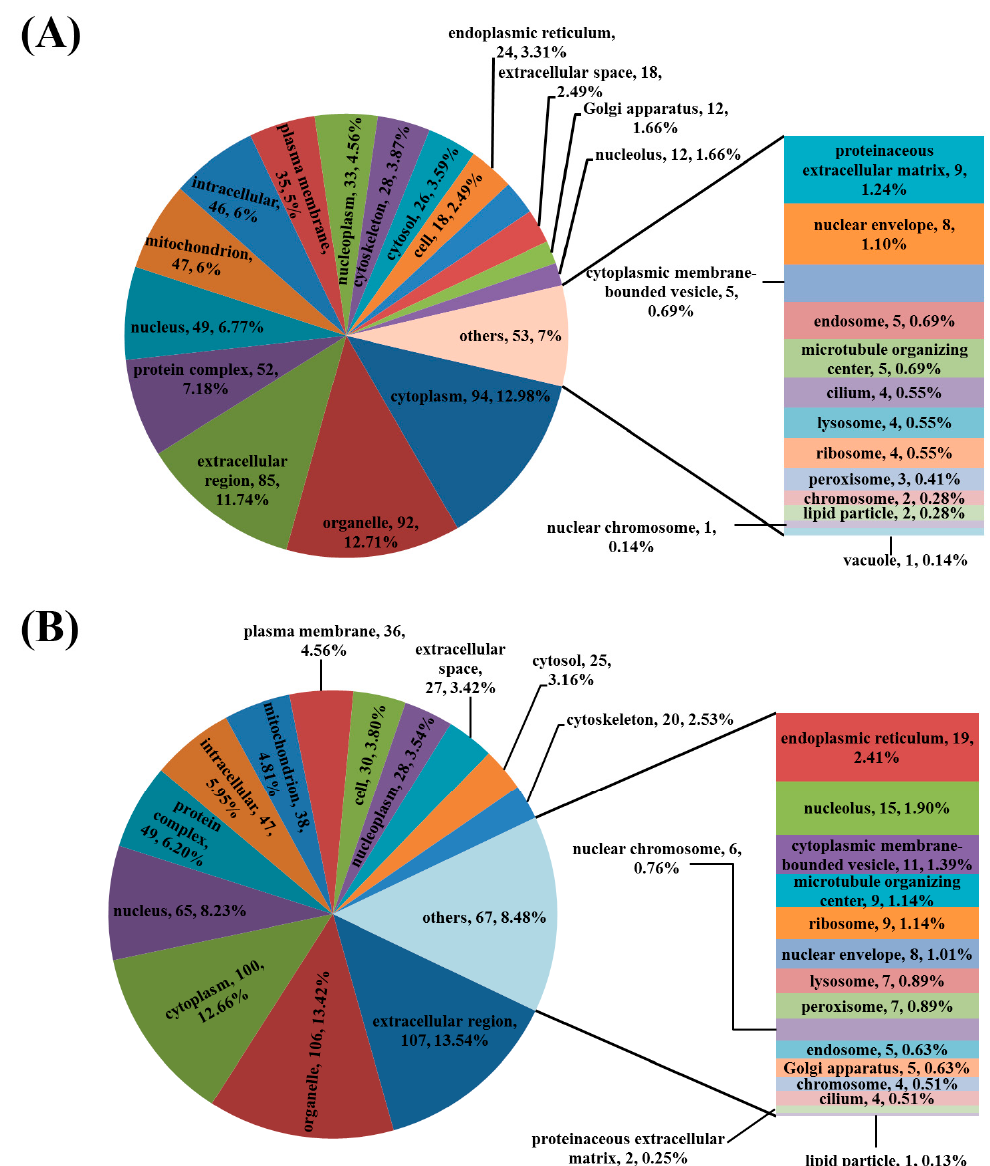
Figure 2. Subcellular location of the differently expressed proteins in jejunum of pigs infected with PEDV. ( A ) Differently expressed proteins in YN13-infected group; ( B ) Differently expressed proteins in YN144-infected group.